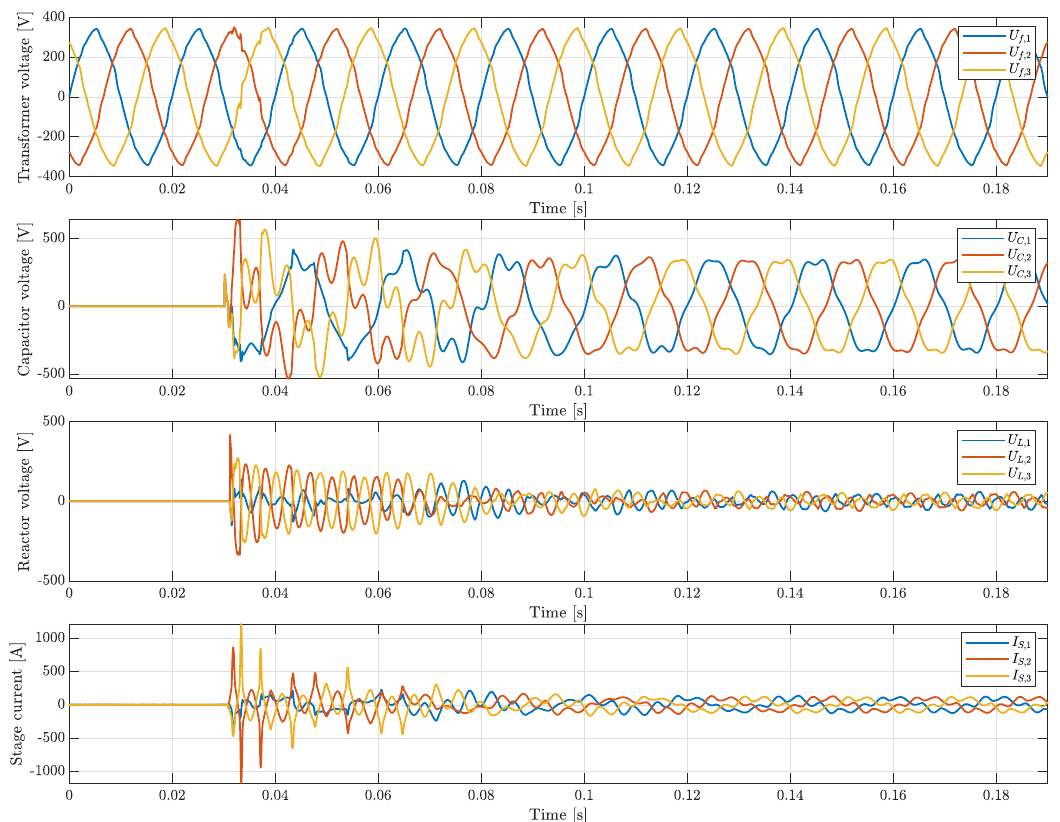
Figure 9. C1—Transformer secondary voltage, capacitor voltage, reactor voltage and stage current when the stage is switched on.